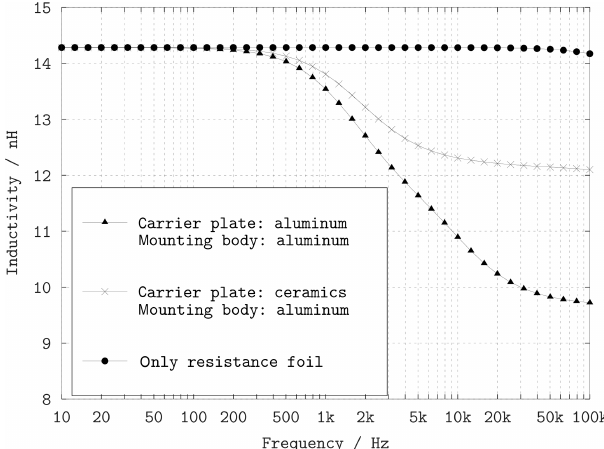
Figure 7. Simulation of the shunt inductance with variation in the assembly of the shunt: carrier plate made of aluminum or ceramics and the resistive foil